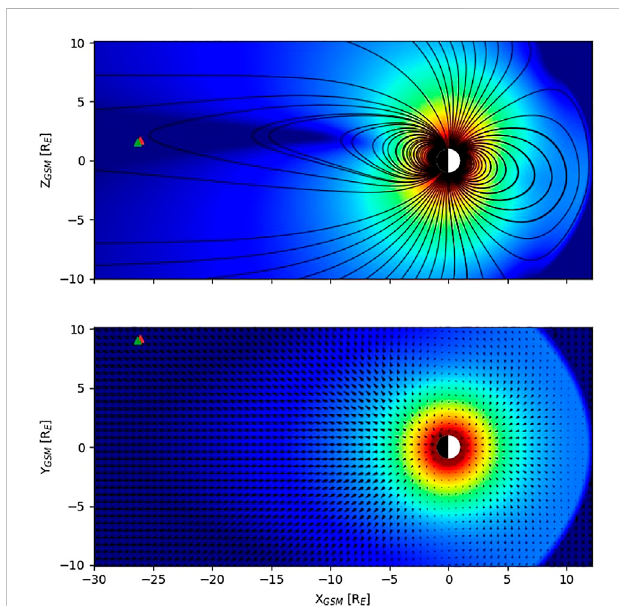
FIGURE 1 Position of MMS spacecraft during two fl apping events on 2020/ 08/26 (red triangle indicates the location of the fi rst event, and green indicates the location of the second event) in the XZ and XY GSM